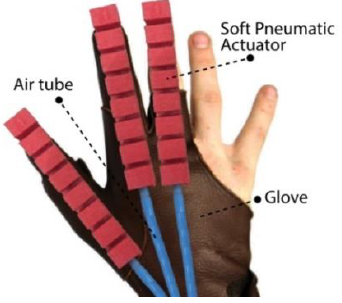
Figure 2. Soft pneumatic actuator (SPA).